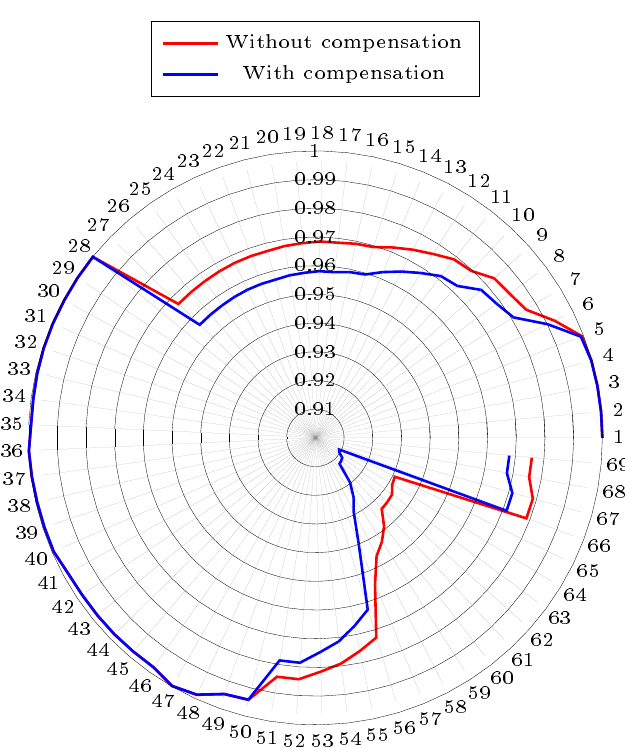
Figure 9. The impact of compensated devices on the voltage profile for the 69-node test